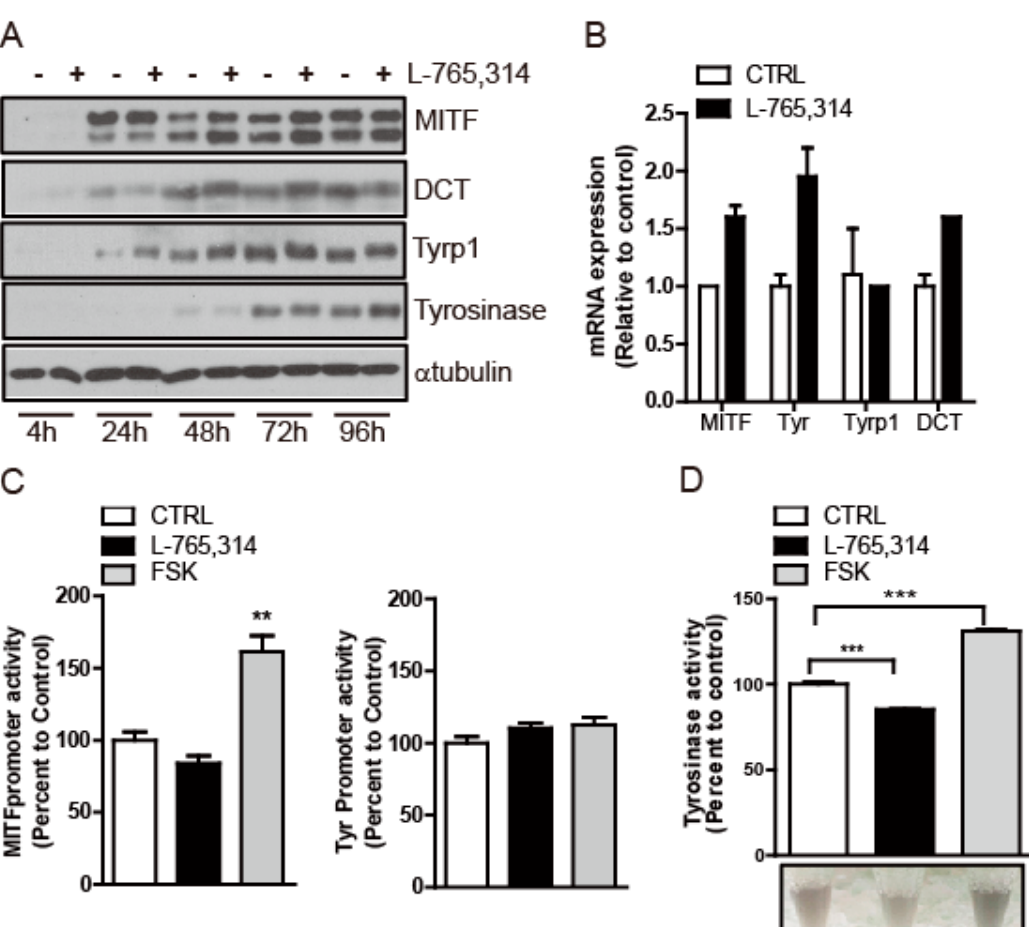
Figure 5. L-765,314 downregulated tyrosinase activity without decreasing tyrosinase expression. ( A ) The expression level of microphthalmia-associated transcription factor (MITF), DCT, Tyrp1, and tyrosinase in Mel-ab cells treated with vehicle and L-765,314 was compared by immunoblotting. α -tubulin was used as an internal loading control. ( B ) The transcript levels of MITF, DCT, Tyrp1, and tyrosinase in L-765,314-treated Mel-Ab cells for 96 h were compared to those of control cells by qRT-PCR. L32 transcript was used as an internal control. ( C ) The effect of L-765,314 on MITF and tyrosinase promoter activity was assessed. Forskolin was used as a positive control for enhancing MITF promoter activity. ( D ) Tyrosinase activity in Mel-ab cells treated with vehicle, L-765,314, or forskolin for 96 h was examined and presented as percent change relative vehicle-treated controls. ** and *** represents p < 0.01 and p < 0.001 respectively.